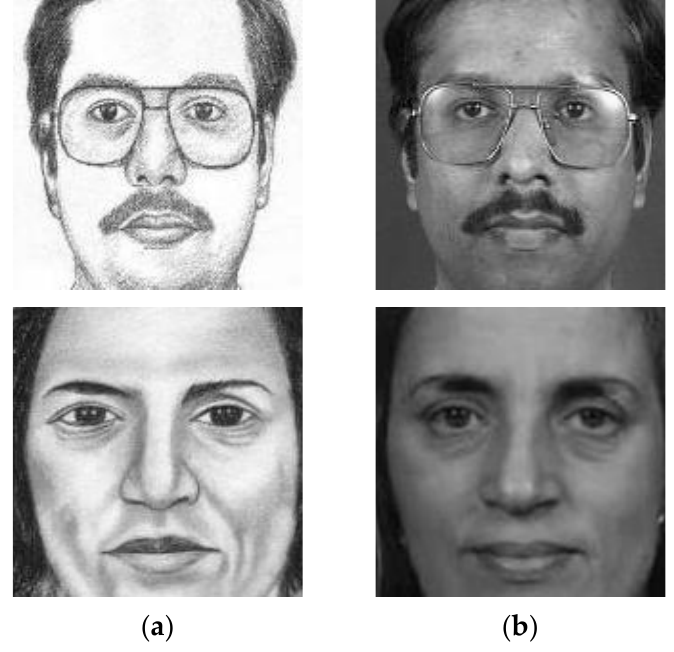
Figure 1. Sample of sketches ( a ) and corresponding photos ( b ).